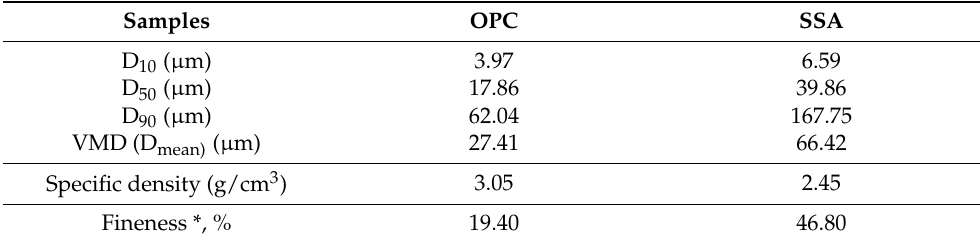
Figure 3. Particle size distribution curves of the tested materials (OPC and SSA). Table 4. Particle size (D 10 , D 50 , D 90 , D mean ), density and fineness of OPC and